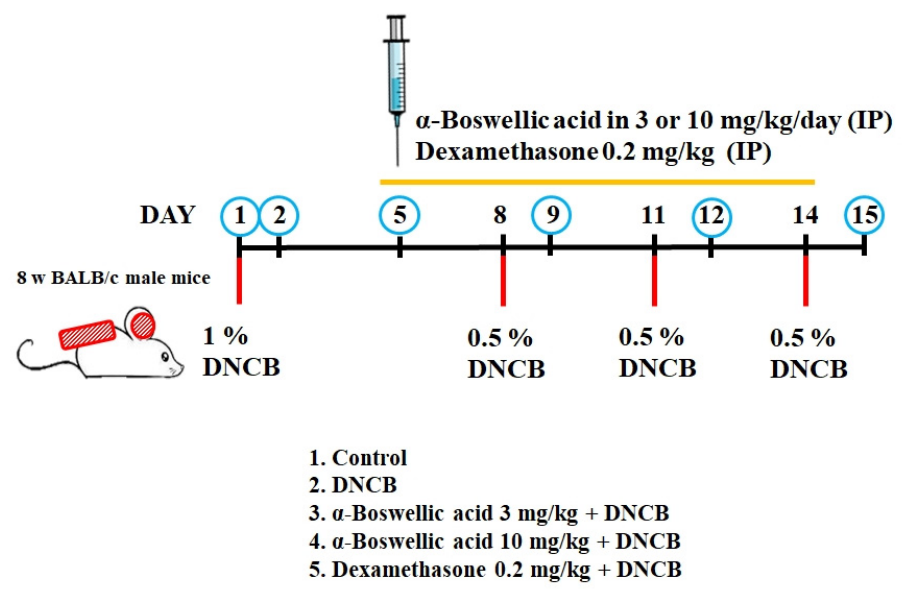
Figure 6. Schematic diagram of the animal experiment. Animal grouping experiments included 1. the normal control group, 2. AD model group (DNCB solution sensitization challenge), 3. and 4. α - boswellic acid group (3 and 10 mg/kg), and 5. positive control group dexamethasone (0.5